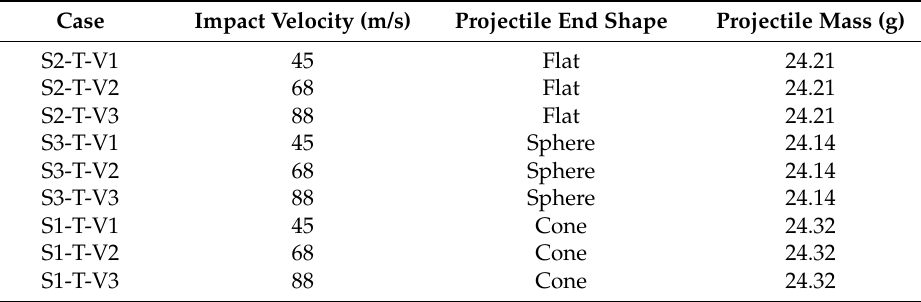
Figure 2. Schematic illustration of high speed impacting system. Table 1. Different conditions in the impact test (with water immersion at 70 °C).